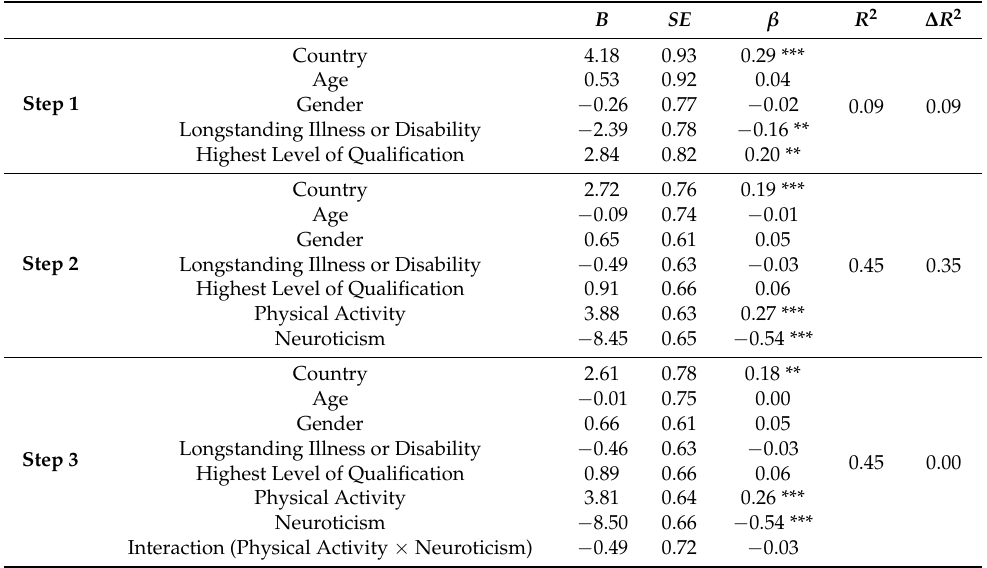
Table 7. Interaction analysis for physical activity and neuroticism.